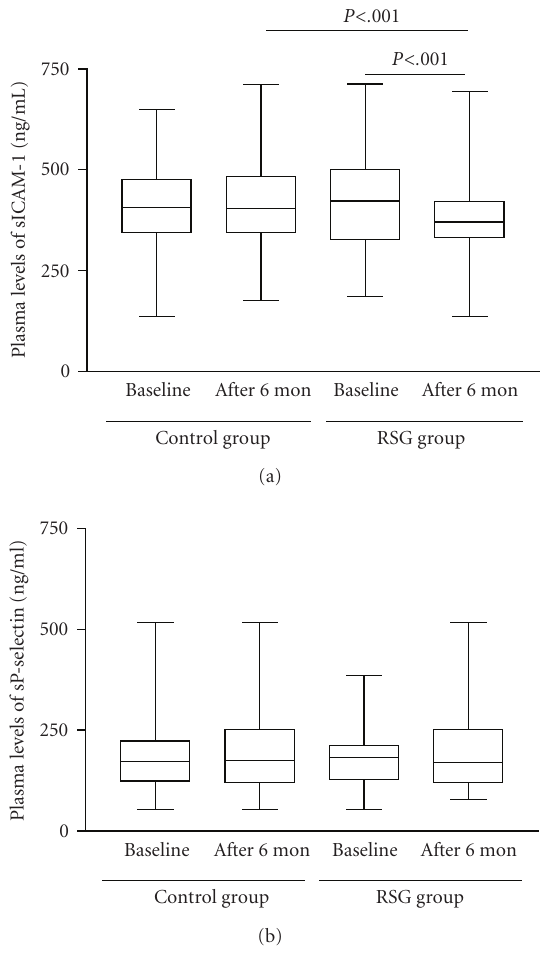
Figure 2: E ff ect of rosiglitazone treatment on plasma levels of soluble ICAM-1 (sICAM-1) (a) and P-selectin (sP-selectin) (b) in patients with diabetes and coronary artery disease after percutaneous coronary intervention. Data are medians and ranges. Control group, n = 56; rosiglitazone (RSG) group, n = 60.